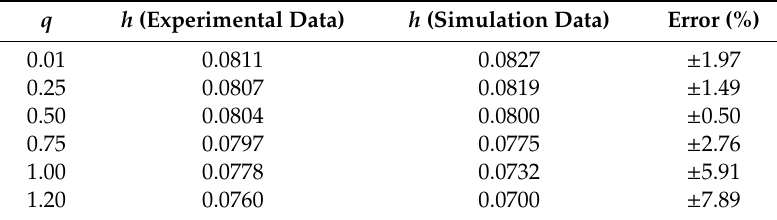
Table 2. Comparison of the experimental and simulation data.